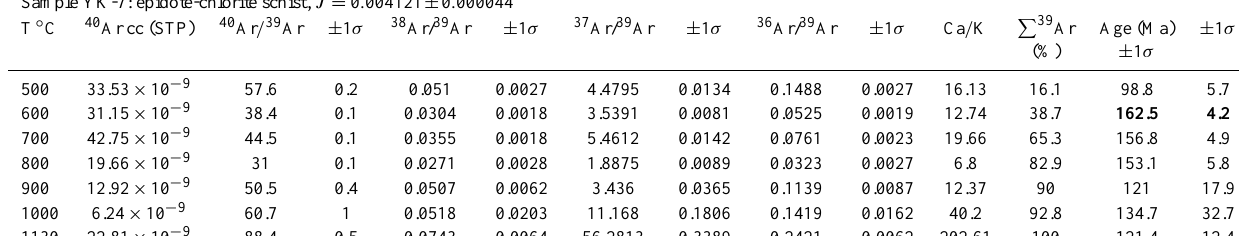
Table 2b. Whole-rock 40 Ar/ 39 Ar age data for an epidote- chlorite schist rock from a metamorphic block in the Ankara Mélange, Turkey. 960 Sample: YK-7: epidote-chlorite schist, J =0.004121±0.000044 T°C 40 Arcc (STP) 40 Ar/ 39